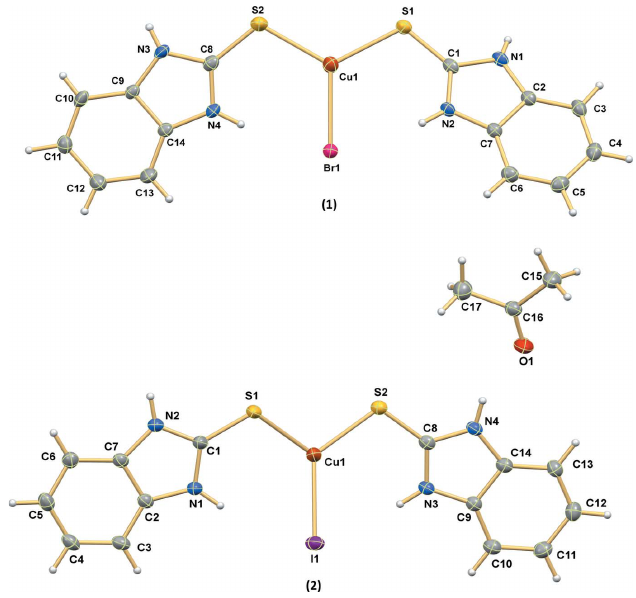
Figure 1 The molecular structures of ( 1 ) and ( 2 ) showing xx% [please supply] displacement ellipsoids.